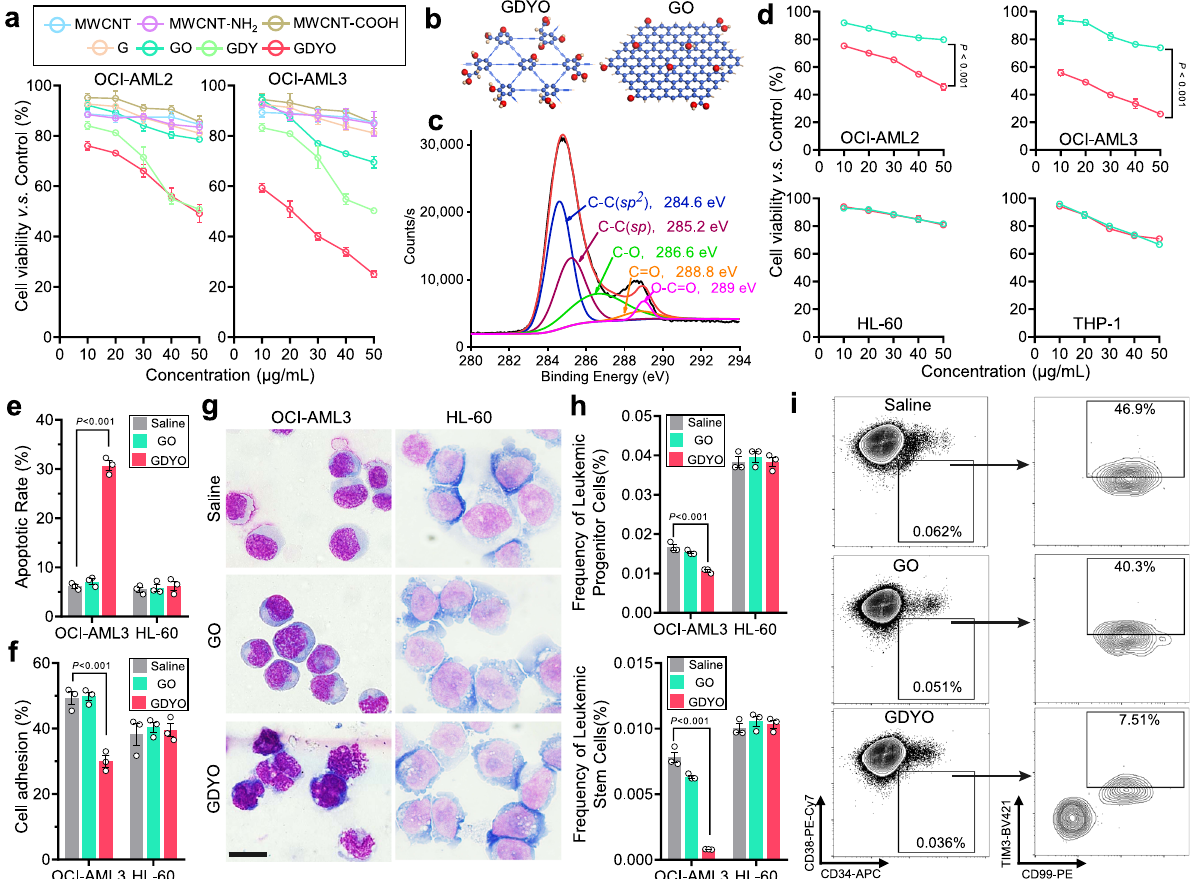
Fig. 2 | GDYO showed anti-leukemia ef fi cacy against DNMT3A mutant AML cells. a Cell viability assay of OCI-AML2 and OCI-AML3 treated with different carbon-based nanomaterials for 24h. n =3 biologically independent experiments . b Schematic illustration showing the structures of GDYO and GO. Carbon and oxygen atoms were shown in blue and red respectively. c C 1s spectra of XPS scan for GDYO. d Cell viability assayof DNMT3A -mutant AML cell lines (OCI-AML2, OCI- AML3) and DNMT3A wildtype AML cell lines (HL-60, THP-1) treated with GO or GDYO at different concentrations for 24h. n =3 biologically independent experi- ments. e Apoptotic rates in OCI-AML3and HL-60treatedwith 20 μ g/mLGO/GDYO